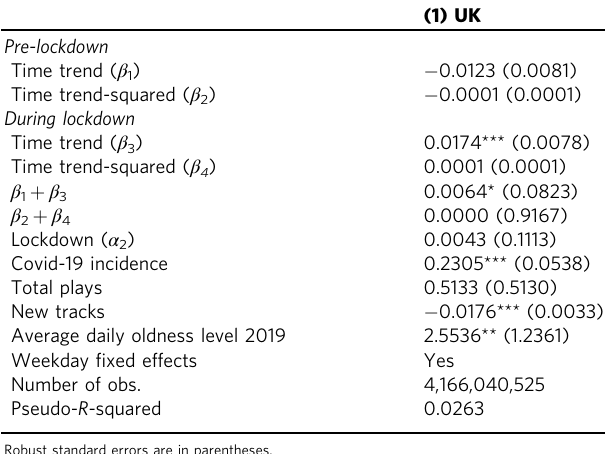
Table 1 Logistic regression of nostalgic music